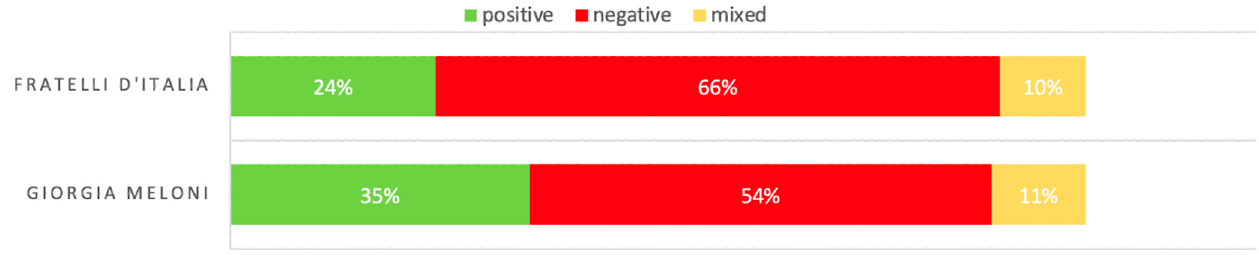
Figure 1. Automatic scanning by the tool FanPage Karma. Reference period: July 2020–June 2021. Meloni’s popularity, from July 2020 to the end of June 2021, stands at 35%, surpassing by 11 percentage points that of Fratelli d’Italia, which stands at 24%. A pull that demonstrates the stubbornness of political personalisation, after succumbing to the logic of the media (Altheide and Snow 1979). For example, according to Ixè, in July 2020, Italians’ trust in Meloni was at 31%, while in May this year in the Ipsos surveys, it stood at 37%. The most telling statistic is connected to Meloni’s success on the number one social platform in terms of the number of users and interactions, namely, Facebook. So much so that in that period, 72% of the talk about her was absorbed by Mark Zuckerberg’s social network (Figure 2). Figure 2. Automatic scanning by the tool FanPage Karma. Reference period: July 2020–June 2021. It is also not possible to depart from these data in order to give a deeper and more prospective interpretation of Fratelli d’Italia’s run-up in the polls (Figures 3 and 4). Moreover, in the period in question, the demoscopic surveys of all the institutes have shown a growth in the consensus on Meloni’s party from 4.5% to 7.5% on average, and this result cannot be improperly dislodged by the presidium that Meloni has made of Facebook.